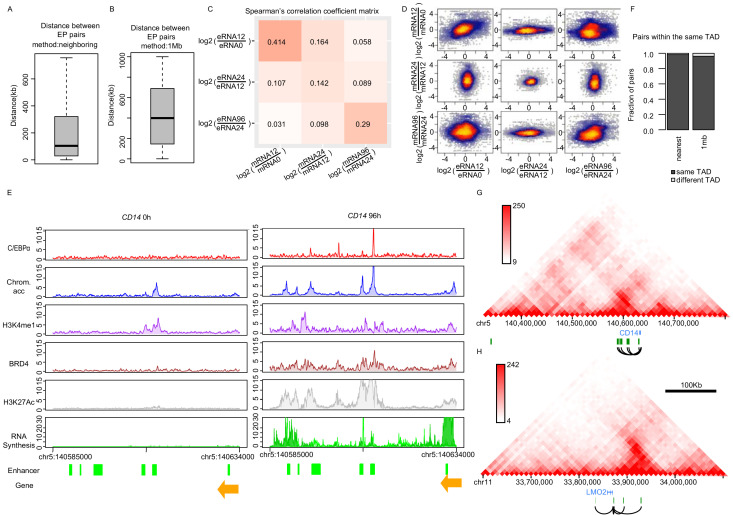
Enhancer–promoter pairing.(A and B) Distance between enhancer–promoter paired by ‘neighboring’ (A) or ‘1 Mb’ (B) methods. (C and D) Spearman's correlation heatmap (C) and scatter plot (D) of log2 fold changes of eRNA and mRNA synthesis from previous time points, using the neighboring method. (E) The exemplary coverage tracks of indicated data sets at CD14 gene are depicted. H3K27Ac coverage track of 72 hr is shown since H3K27Ac ChIP-seq at 96 hr is not available. (F) Fraction of EP pairs from indicated method overlapping with TAD obtained from Hi-C data. (G and H) Positions of enhancers paired with CD14 (G) and LMO2 (H) with chromatin contact information (HiC data from THP-1 cells [Phanstiel et al., 2017]) indicate that these enhancers have high contact frequency (orange: genes, green: enhancers, black lines: pairs).